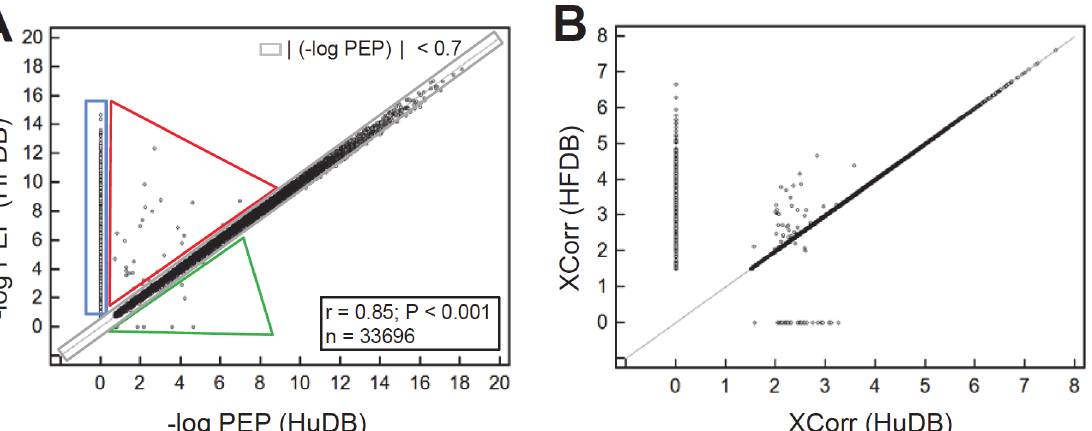
Fig 3. Distribution of posterior error probability (PEP) and Xcorr values for PSMs of Calu-1 secretome fractionated by OFFGEL fractionator. (A) -logPEP values are compared between each pair of peptide-spectrum matches (PSMs). The region where | Δ (-logPEP)| < 0.7 between HuDB and HFDB search results is marked grey. Spectra in blue area have PSMs in the HFDB, but not in HuDB search result. Spectra in red area have higher -logPEP value (more than 0.7) for the PSMs of HFDB than for HuDB search results. The reverse is true for the spectra in green area. (B) Distribution of XCorr values for HFDB vs. HuDB search